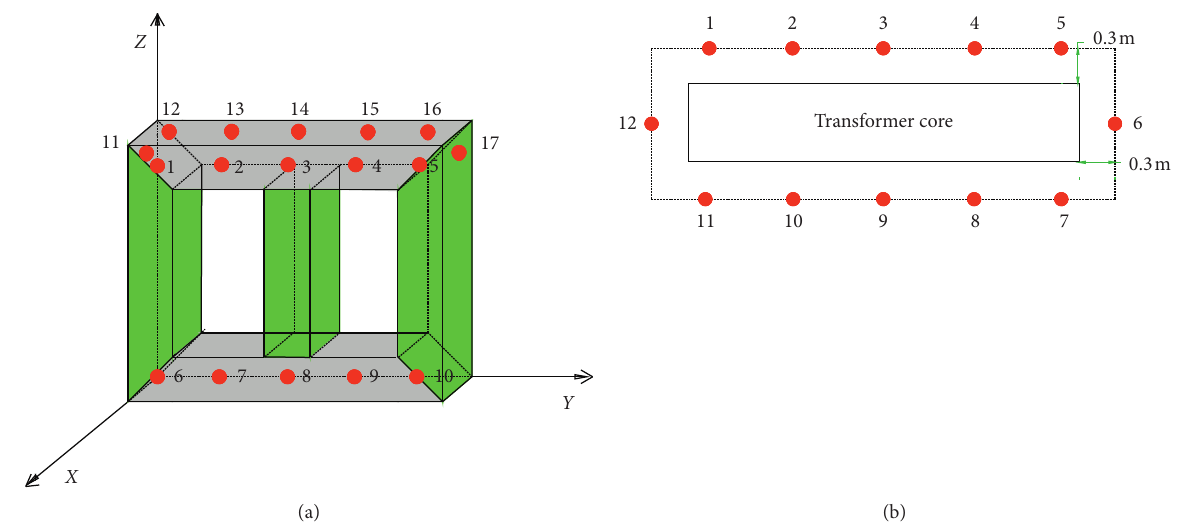
Figure 3: Noise and vibration measurement points. (a) Vibration measurement points (Nos.1–10 in the vertical core plane and Nos. 11–17 in the parallel core plane). (b) Noise measurement points.